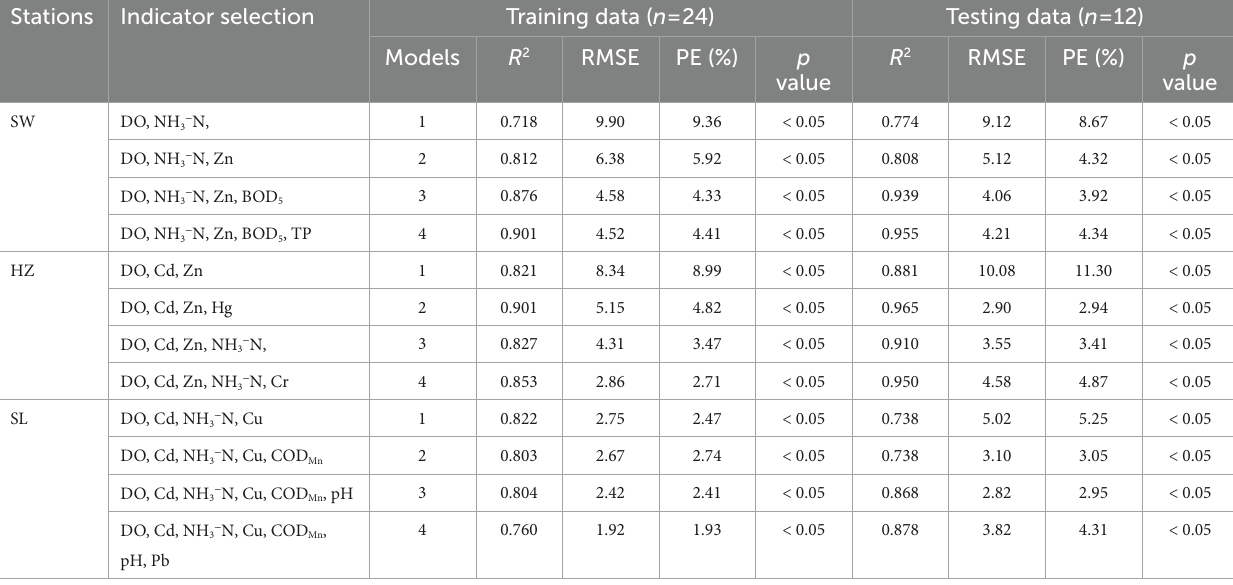
TABLE 4 The indicator selection results of the WQI min models using the stepwise multiple linear regression. Stations